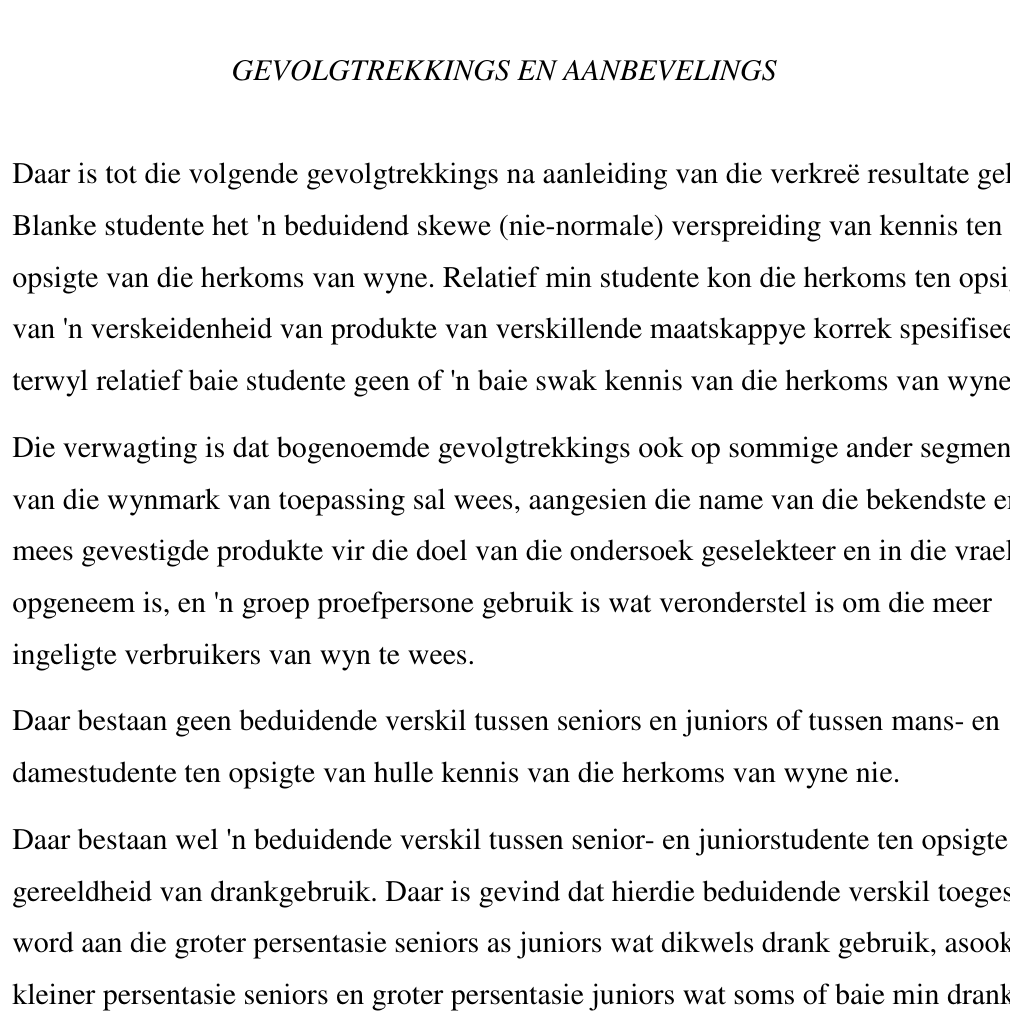
GEVOLGTREKKINGS EN